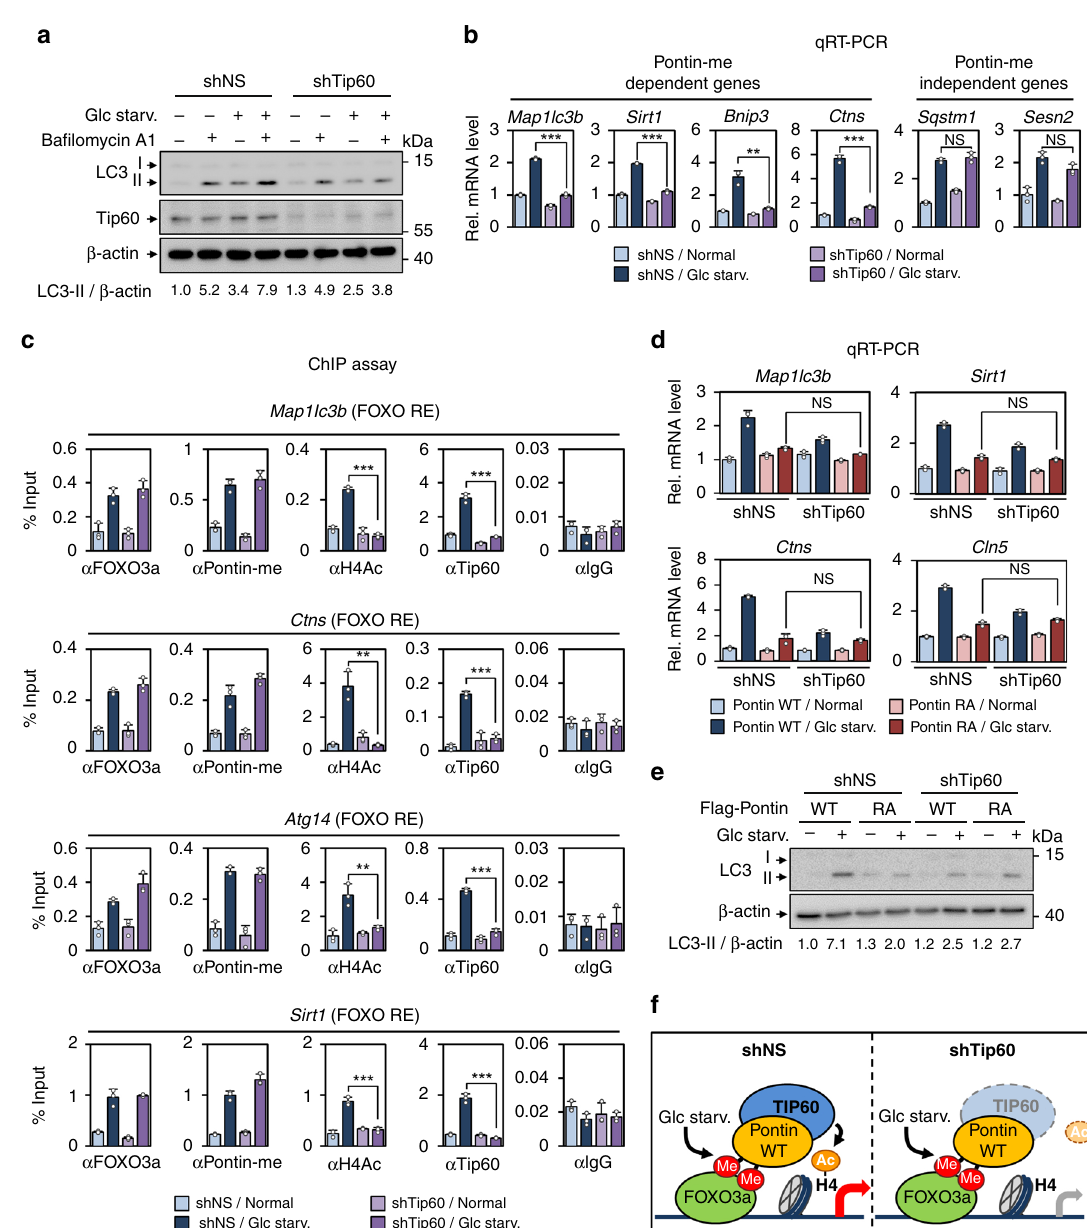
Fig. 7 Pontin and Tip60 complex is important for autophagic occurrence through the regulation of FOXO3a target genes. a Autophagic fl ux was analyzed in MEFs after knocking down with shRNA for Tip60 (shTip60) or non-speci fi c shRNA (shNS) in the presence or absence of Ba fi lomycin A1 (200 nM; 2 h) under glucose starvation. The LC3-II/ β -actin ratio is indicated. b Quantitative RT-PCR analysis of methylated Pontin-dependent genes and independent genes in MEFs by knocking down with either shNS or shTip60 in the absence or presence of glucose starvation. Bars, mean ± s.e.m; n = 3; ** p < 0.01, *** p < 0.001, NS non-signi fi cant. Statistics by two-tailed t -test. c ChIP assays were performed using anti-FOXO3a, anti-Pontin-me, anti-H4ac, anti-Tip60, and anti-IgG antibodies on FOXO REs in MEFs by knocking down with either shNS or shTip60 in the absence or presence of glucose starvation. Bars, mean ± s.e.m; n = 3; ** p < 0.01, *** p < 0.001. Statistics by two-tailed t -test. d Quantitative RT-PCR analysis of methylated Pontin-dependent autophagy and lysosomal genes in Pontin WT or RA MEFs with or without Tip60 knockdown. Bars, mean ± s.e.m; n = 3; NS non-signi fi cant. One-way ANOVA with post hoc Tukey ’ s test. e Immunoblot analysis of LC3 levels in Pontin WT or RA MEFs with or without Tip60 knockdown. The LC3-II/ β -actin ratio is indicated. f Schematics for the transcriptional activation of FOXO3a and methylated Pontin-dependent autophagy genes regulated by Tip60 with increased H4 acetylation upon glucose starvation. Glucose starvation-induced methylated Pontin by CARM1 at R333 and R339 residues binds FOXO3a through a methyl binding domain of FOXO3a along with Tip60 following increased H4 acetylation. Source data are provided as a Source Data fi